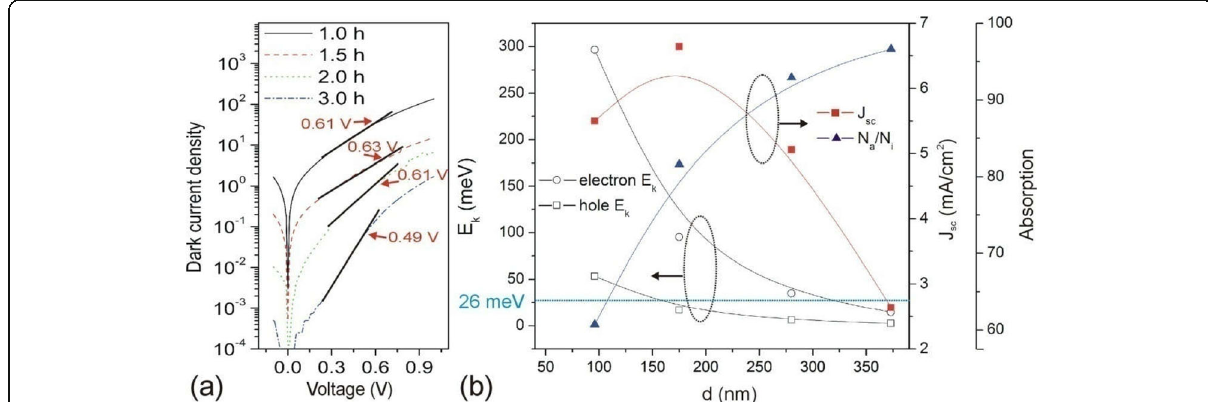
Fig. 7 a Semilogarithmic plots of J – V characteristic in the dark of the solar cells with different CBD t for Sb 2 S 3 film. b Dependences of V in , J sc , N a / E E N i , ke , and kh on Sb 2 S 3 thickness